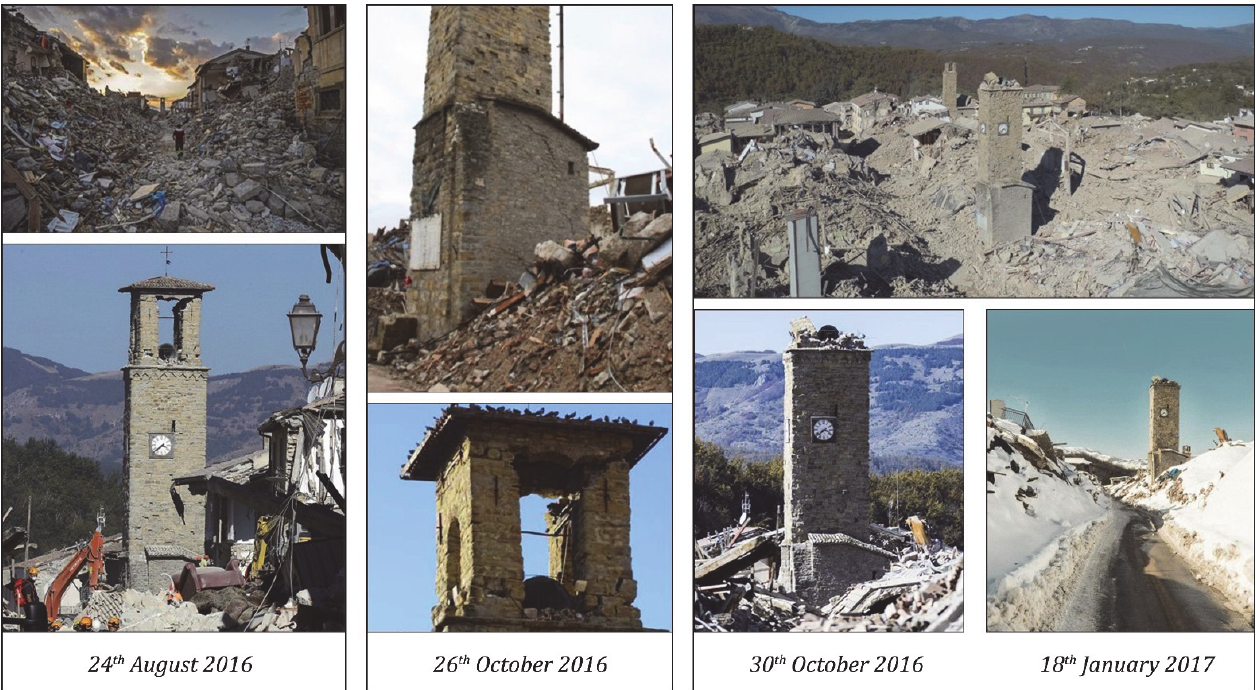
Figure 6: Views of the damaged civic clock tower of Amatrice (Rieti, Italy) after the main shocks of the Central Italy seismic sequence of